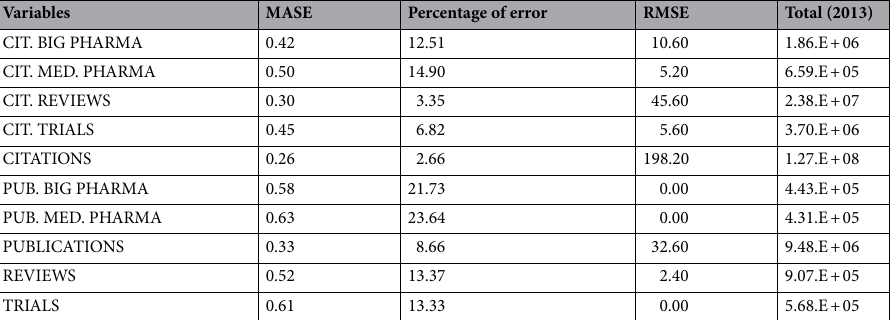
Table 5. Performance of the predictions. Performance in the predictions of the publication dynamics. The model predicts the publications dynamics per gene between 2014 to 2019 using data from 1980 to 2013. Numbers represent the median 13,380 human genes. MASE mean accuracy scaled error, RMSE root mean square error, Total number of elements in the database up to